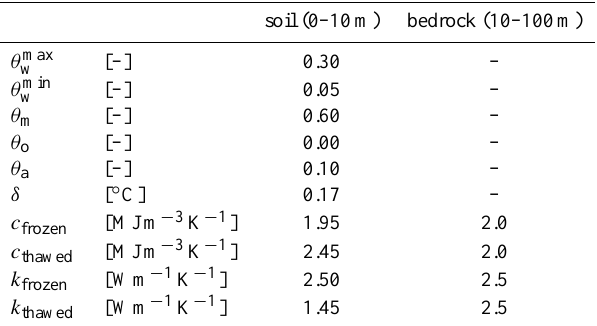
Table 2. Thermal properties employed to describe the ground in the